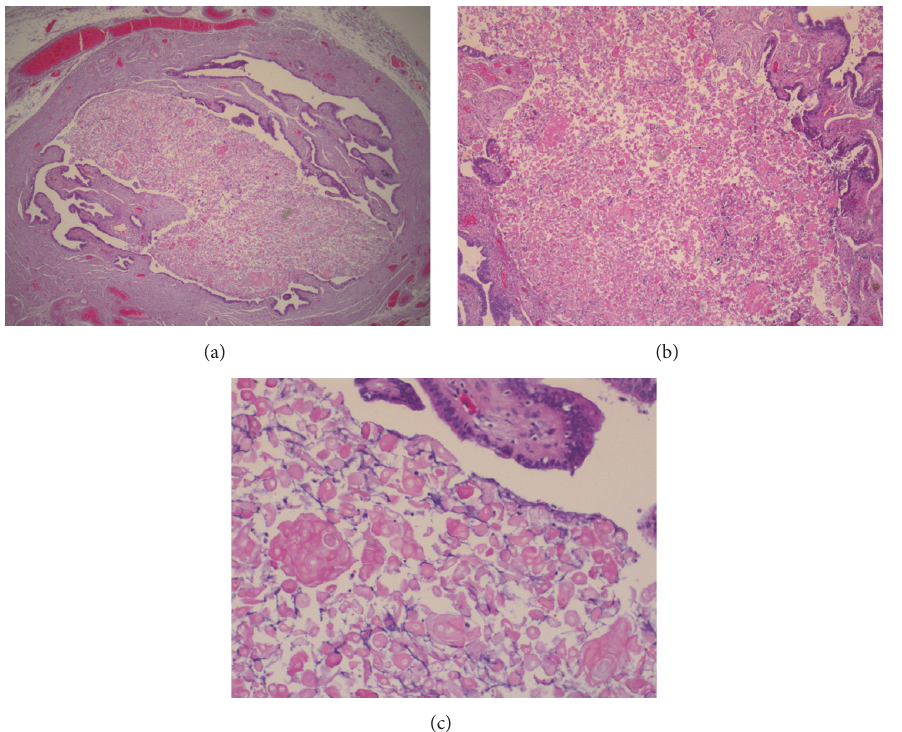
Figure 7: H&E stain: similar to Figure 6, degenerate squamous cells are filling and distending the lumen of the fallopian tubes (in various magnifications).